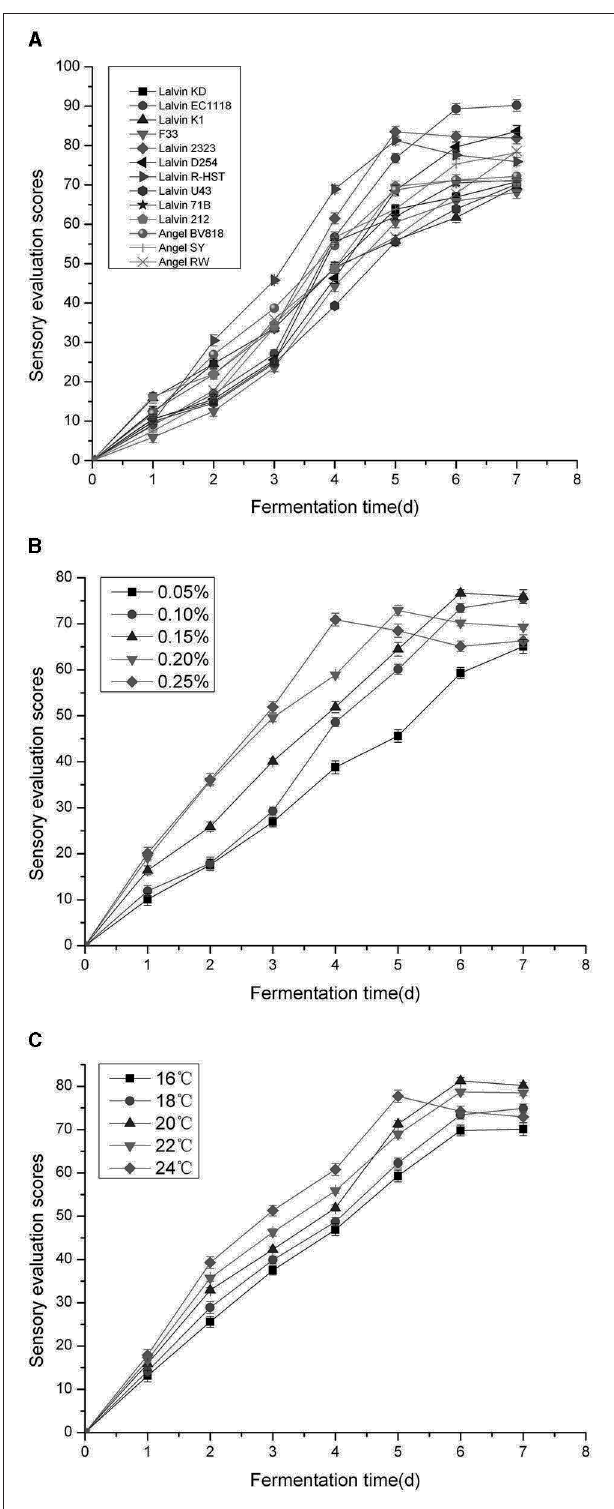
FIGURE 1 | Effects of different Saccharomyces cerevisiae strains (A) , yeast amounts (B) , fermentation temperatures (C) on sensory evaluation scores of Niuxin plum